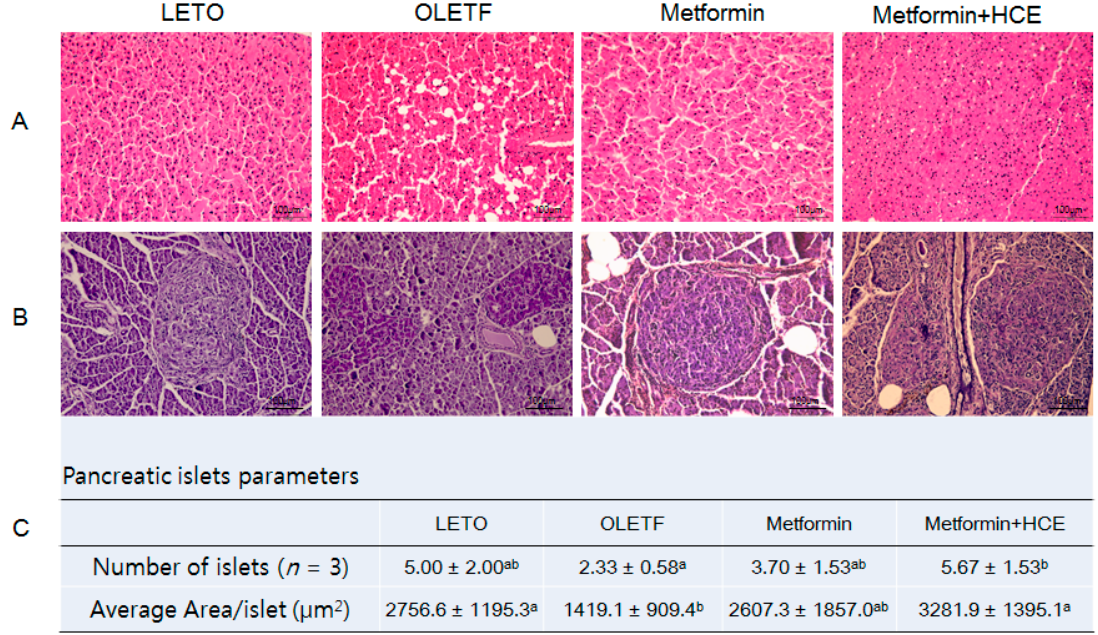
Figure 6. Effect of metformin either alone or in combination with HCE on the histological architecture of the liver and pancreas, and the abundance of pancreatic islets in OLETF rats. At the termination of the experimental period, the liver ( A ) and pancreas ( B ) were excised rapidly following which tissue sections were prepared and stained with hematoxylin. The histological examination of the tissue sections was performed under a light microscope (200× magnification). Number of pancreatic islets and average area/islet are shown ( C ). Data with different letters are significantly different ( p < 0.05) according to one way ANOVA analysis.